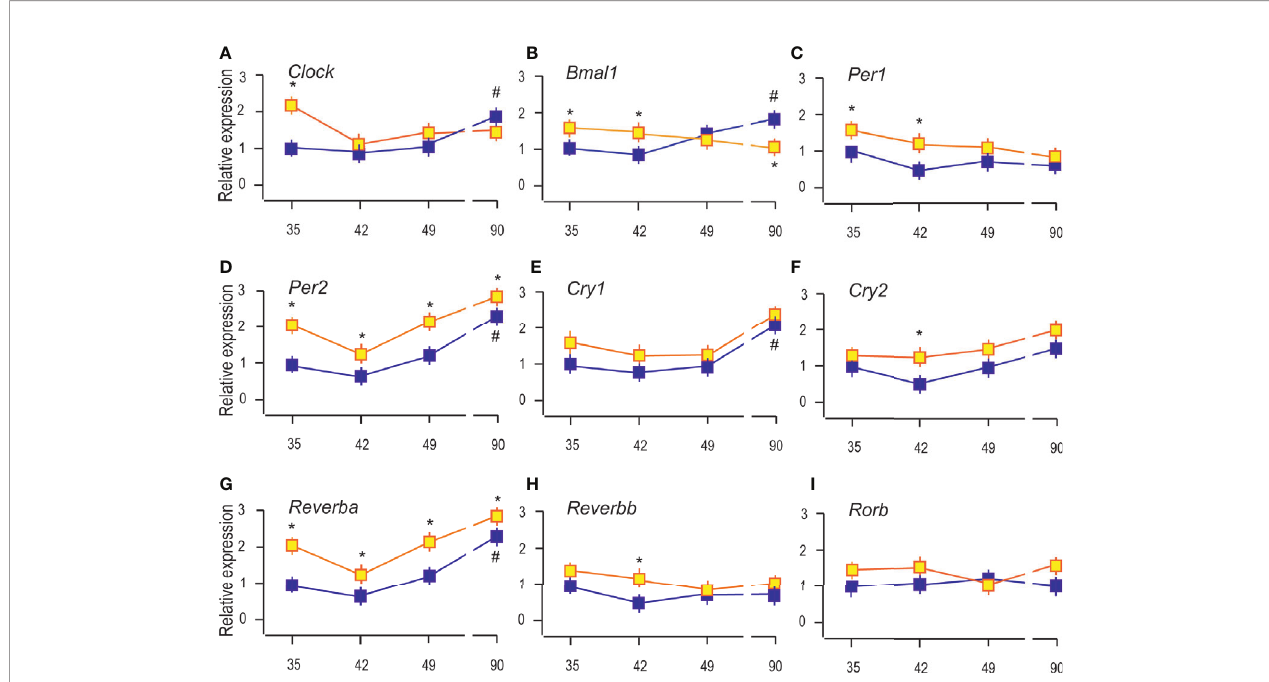
FIGURE 5 | Constant light changed the expression of clock genes in Leydig cells. RNAs were isolated from Leydig cells obtained from rats of different ages of both (LD and LL) groups and transcription of clock genes were estimated by qRT-PCR. The transcription of positive clock elements (A, B) and negative elements (C – F) from primary clock loop together with elements from the secondary loop (G – I) was shown. Data points represent group means ± SEM values (n = 5). *Statistical signi fi cance at level p < 0.05 compared to the corresponding LD group; # Statistical signi fi cance at level p < 0.05 compared to the P35 LD